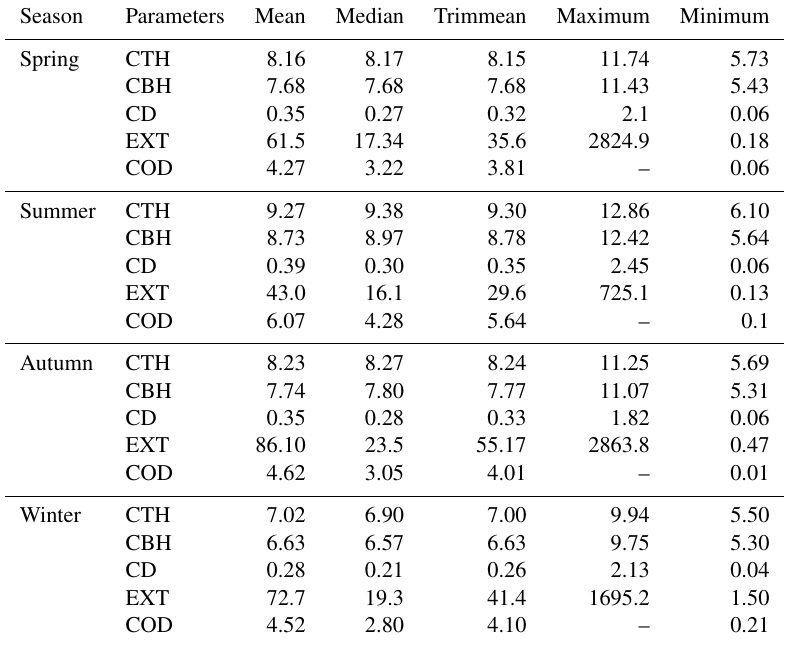
Table 1. Statistical results for the cloud-top height (CTH), cloud-base height (CBH), cloud depth (CD), horizontal extent (EXT) and cloud optical depth (COD) in the four seasons. The “trimmean” is the 10% trimmed mean of portion clusters, excluding 10% of clusters with the highest and lowest values (unit: